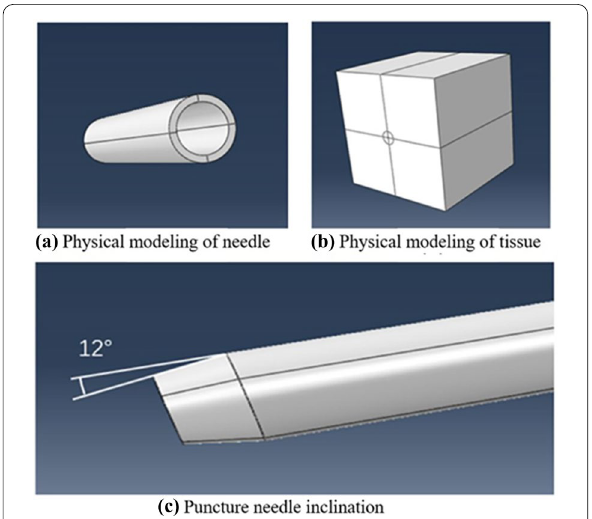
Figure 6 Establishment of finite element geometric